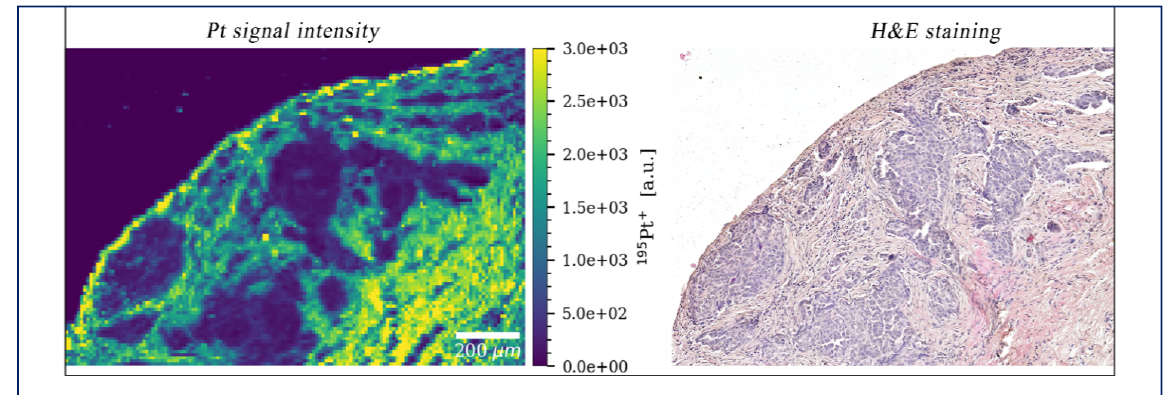
Figure 2. Platinum (Pt) penetration after HIPEC using cisplatin in a patient with peritoneal metastases from ovarian cancer. When comparing Pt penetration with histology, it is obvious that Pt penetrates the stroma much more efficiently compared to the nests of cancer cells.